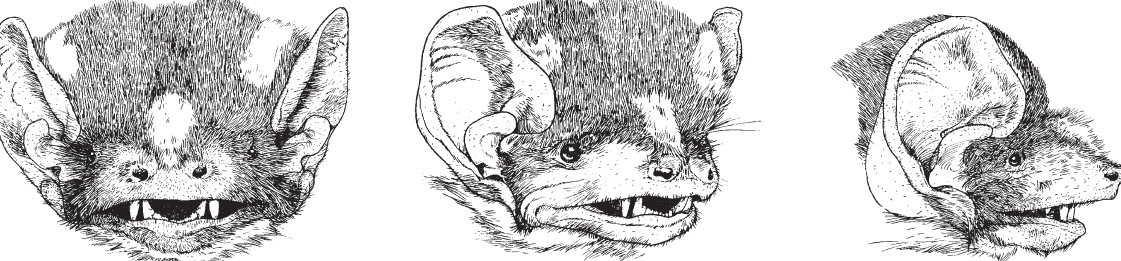
Fig. 4. Head of Glauconycteris superba Hayman, 1939 from Matonguiné (RMCA